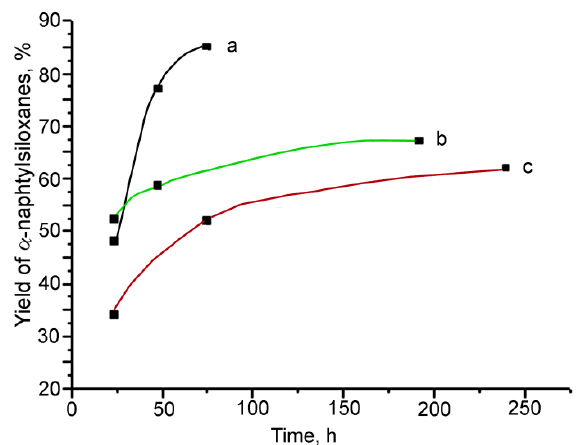
Figure 9. Dependence of the yields of α -naphthylsiloxanes from the hydrolysis–condensation reaction of compound 3 on time at different C HCl in water-acetone solutions: ( a ) C HCl = 0.37, ( b ) 0.15, and ( c ) 0.037 mol L −1 .